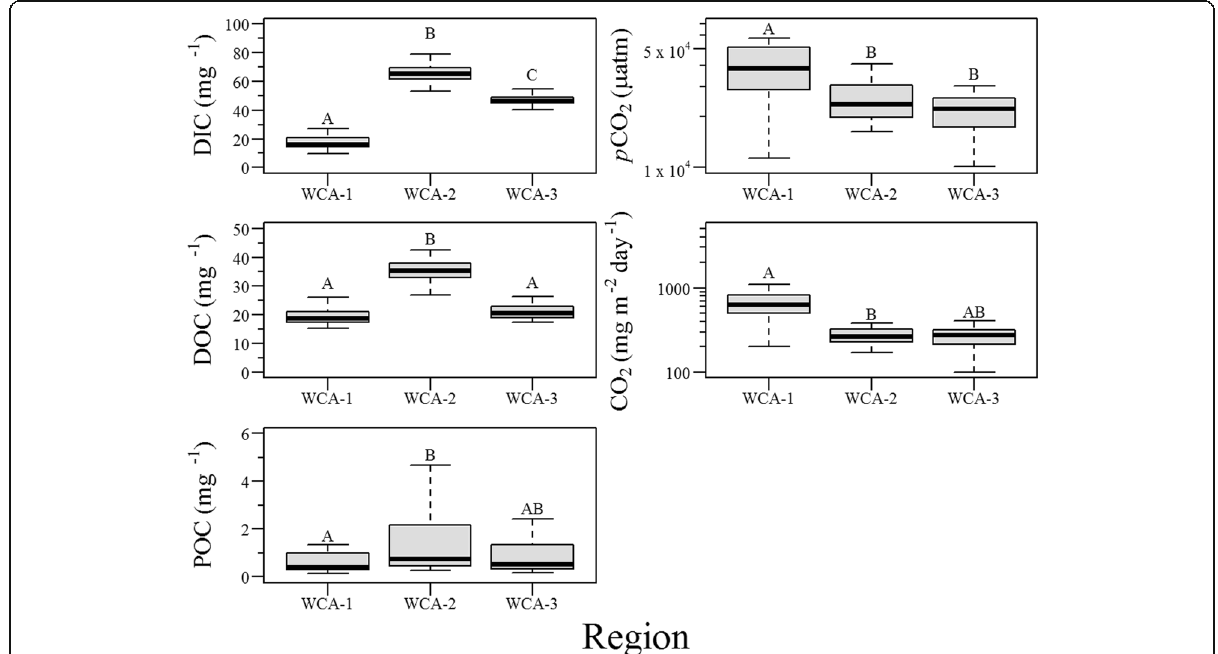
Fig. 4 Boxplot of annual mean dissolved inorganic concentration, dissolved organic carbon, particulate organic carbon, and surface water pCO 2(aq) concentration for each region of the Everglades Protection Area. Letters above box-and-whicker plots indicate statistical differences based on